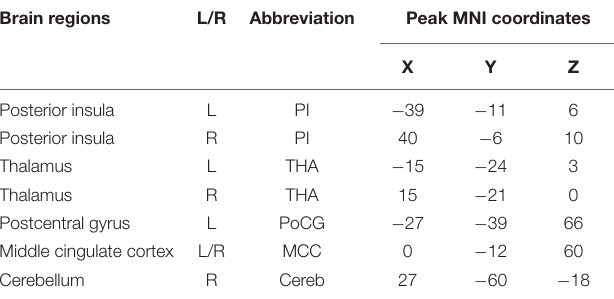
FIGURE 5 | Correlation analyses between functional connectivities and clinical measures. Correlation analyses identified a significantly positive correlation between VAS scores and functional connectivities of the right posterior insula (PI.R) with left thalamus (THA.L), and negative correlations between VAS scores and the functional connectivities of the middle cingulate cortex (MCC) to left postcentral gyrus (PoCG.L) in CDP patients.